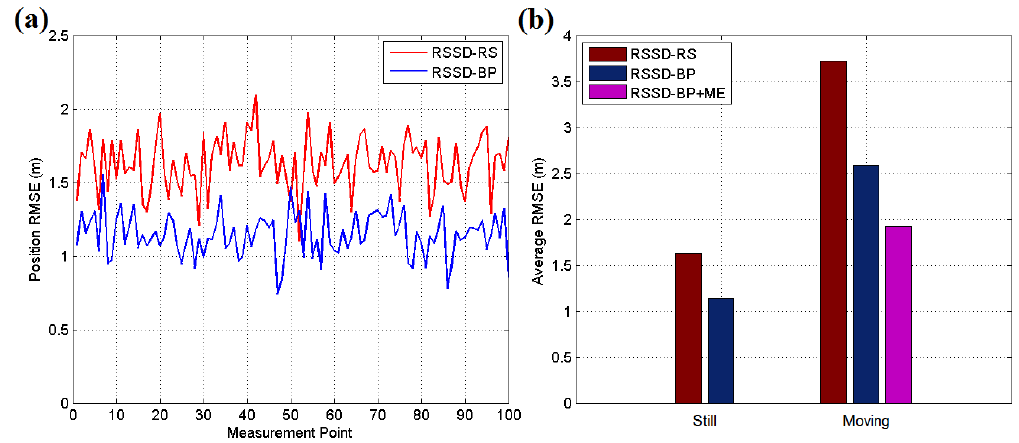
Figure 20. ( a ) RMSE of the still target for each testing position in scenario 3; ( b ) Average RMSE of still and moving targets in testing scenario 3.